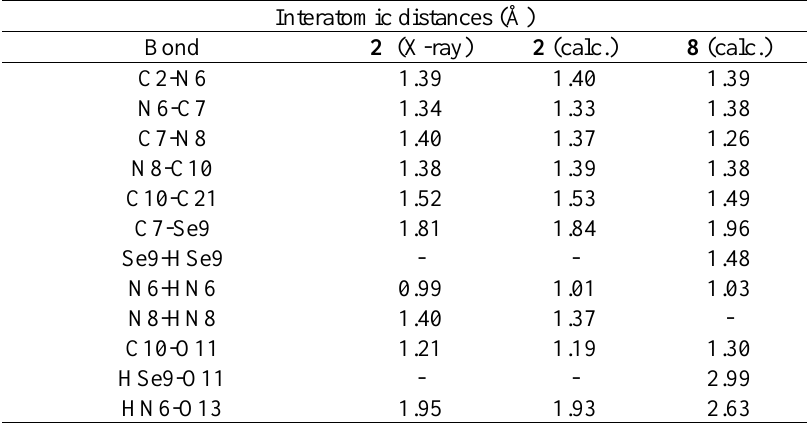
Table 1. Selected interatomic distances (Å) in 2 and 8 .